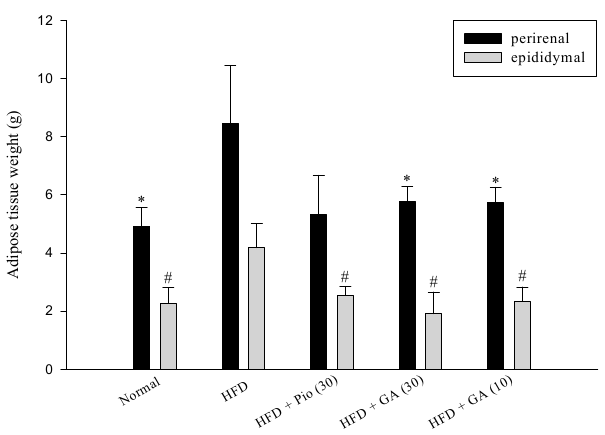
Figure 1. The perirenal and epididymal adipose tissues weight of HFD rats after being fed with GA for four weeks. GA: gallic acid; Normal: Normal rats were treated with saline; HFD: High fructose diet rats were treated with saline; HFD + Pio (30): High fructose diet rats treated with pioglitazone (30 mg/kg body weight); HFD + GA (30): High fructose diet rats treated with gallic acid (30 mg/kg body weight); HFD + GA (10): High fructose diet rats treated with gallic acid (10 mg/kg body weight). Values calculated as mean ± SD for six rats in each group. * p < 0.05, versus HFD rat for perirenal adipose. # p < 0.05, versus HFD rat for epididymal adipose tissue.